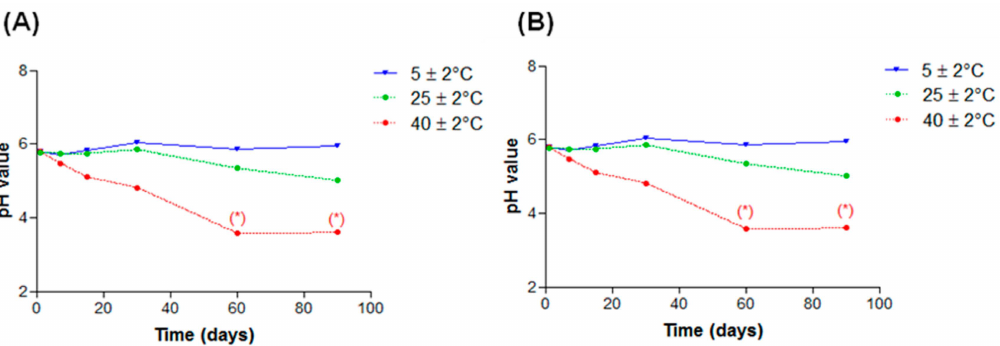
Figure 10. pH values in function of time of nanoemulsions subjected to different storage temperatures: ( A ) EL and ( B ) AL. * p < 0.05.